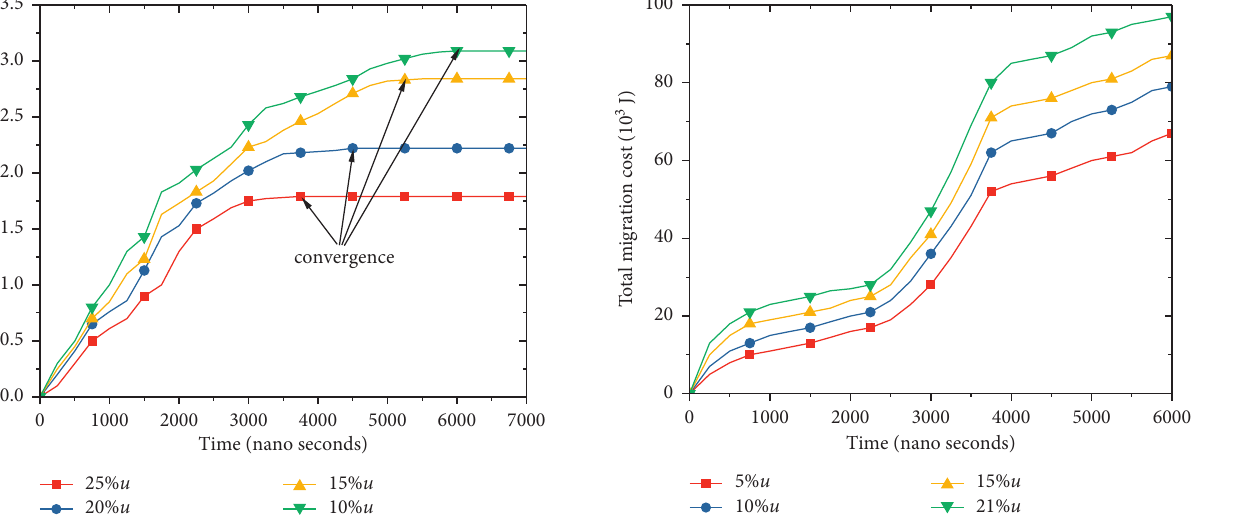
Figure 6: The number of iterations versus time and B .